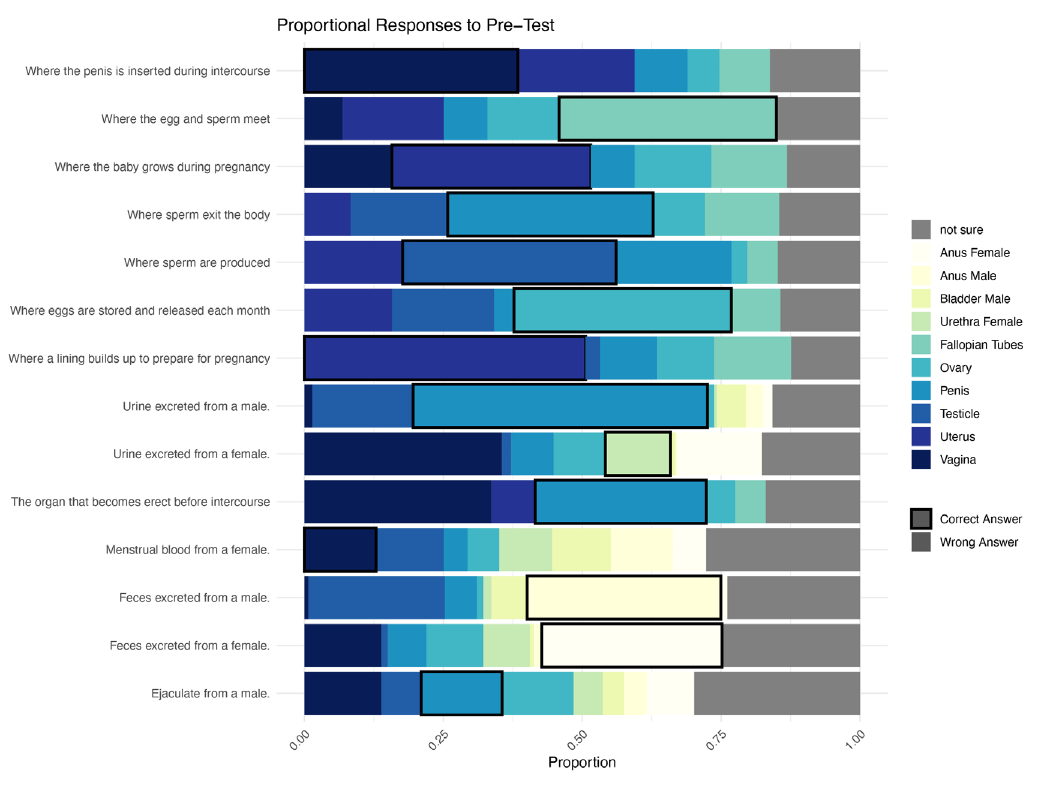
Figure 8. Pre-test responses by question. The highlighted bar shows the correct answer in every instance. N=419.